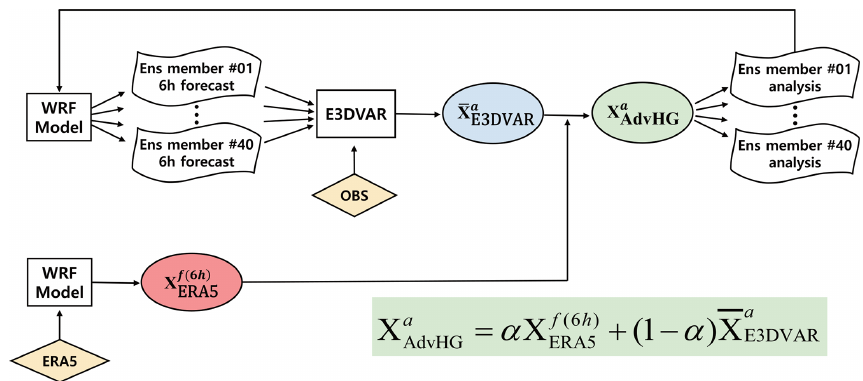
Figure 2. Schematic diagram of the advanced hybrid gain data assimilation method in the East Asia Regional Reanalysis